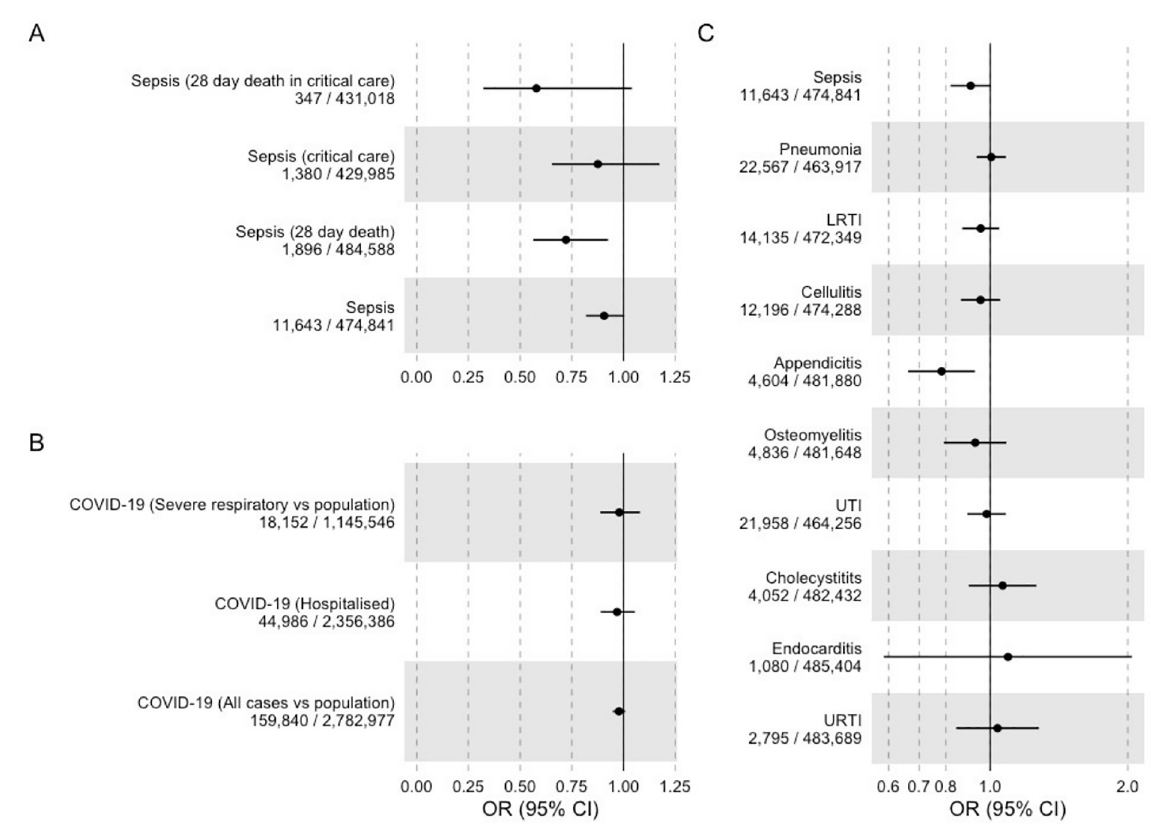
Fig 4. IVW MR effect estimates for CRP from cis CRP variants and each outcome (A: Sepsis, B: COVID, C: other infections). CI, confidence interval; COVID-19, Coronavirus Disease 2019; CRP, C-reactive protein; IVW, inverse variance weighted; LRTI, lower respiratory tract infection; MR, Mendelian randomisation; OR, odds ratio; URTI, upper respiratory tract infection; UTI, urinary tract infection.